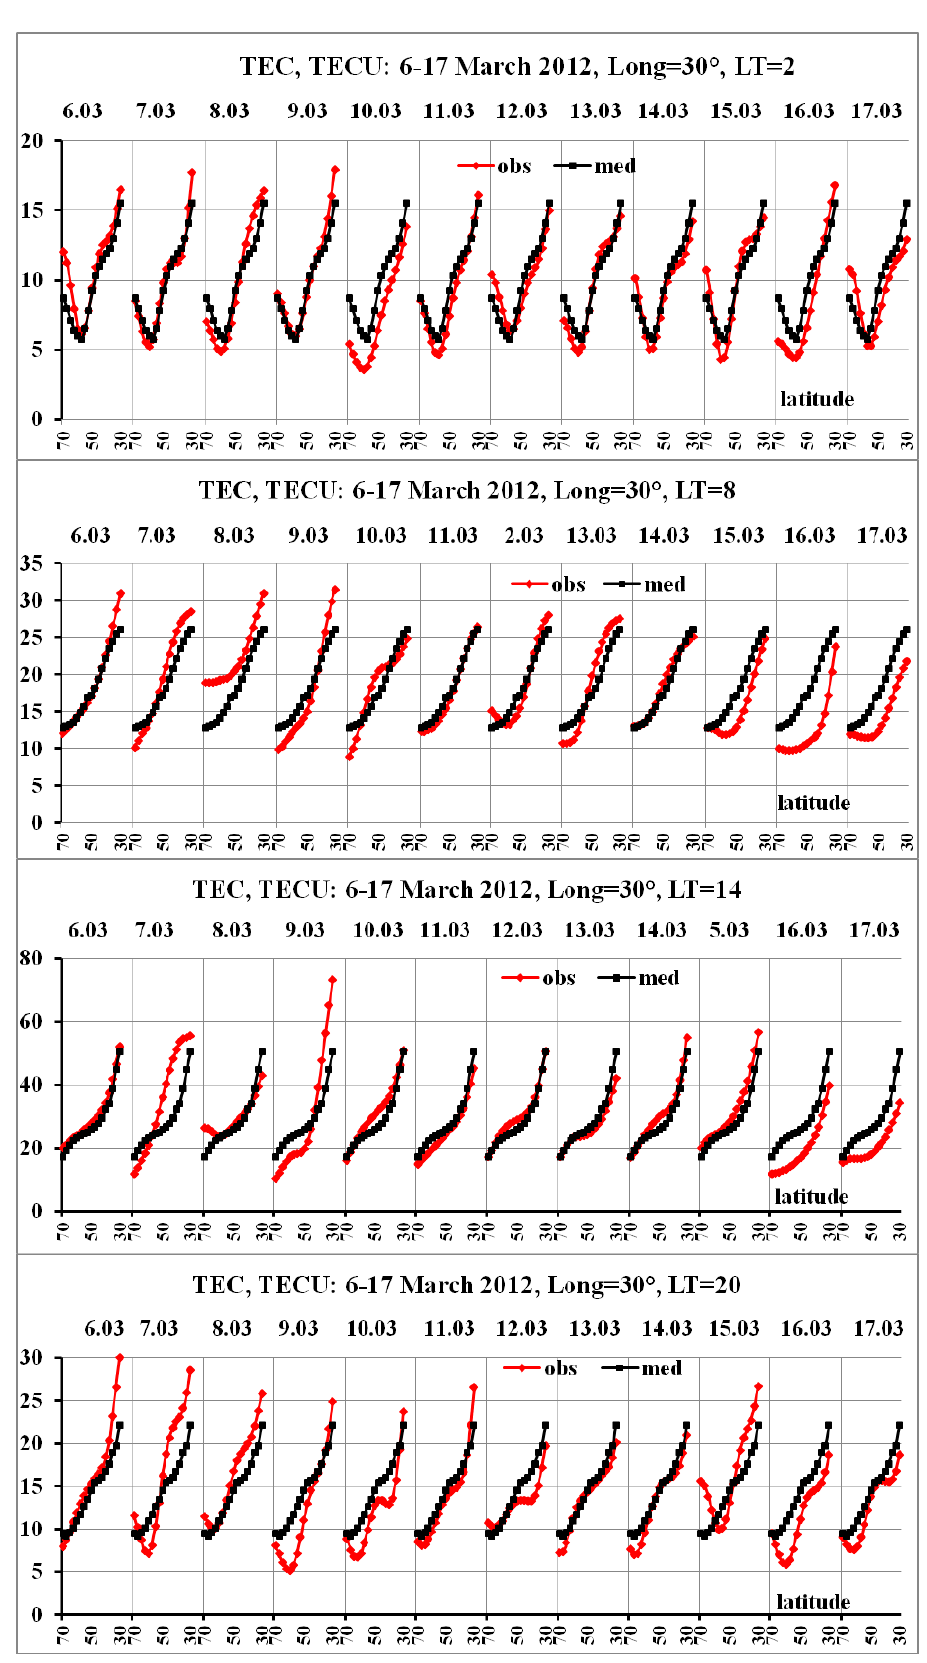
Figure 7. The response of the TEC parameter to the disturbances of March 7-17, 2012, at various hours of the day.